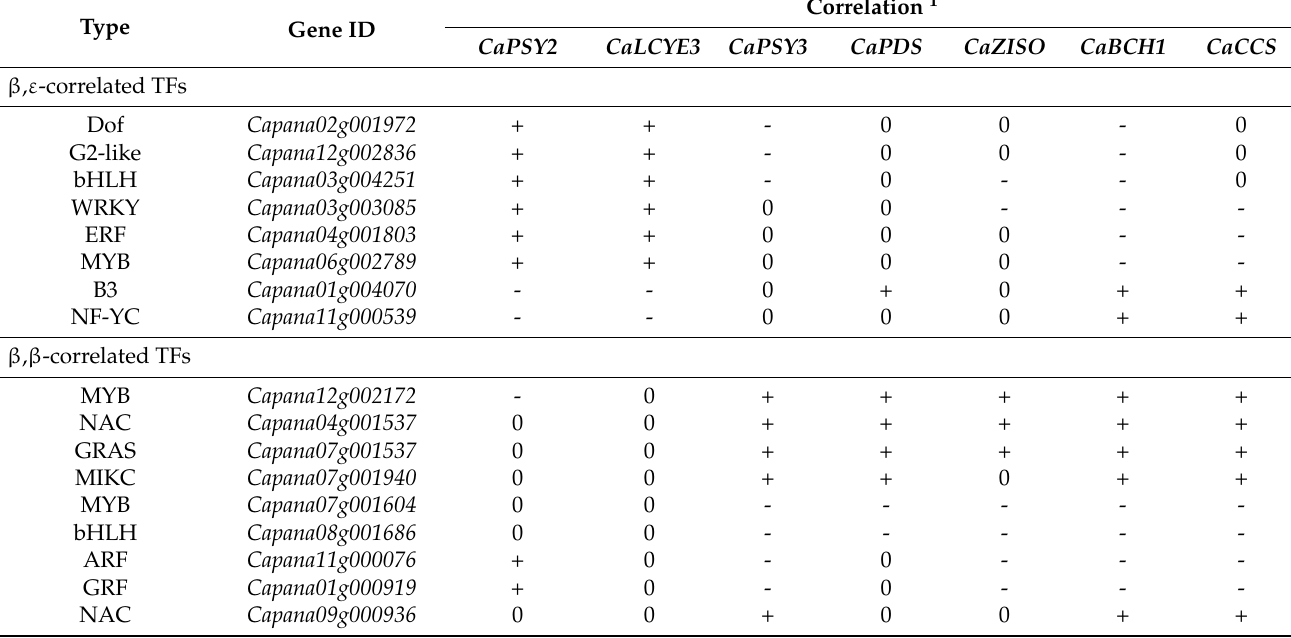
Table 2. Transcription factors co-expressed with carotenoid biosynthetic genes in chili pepper